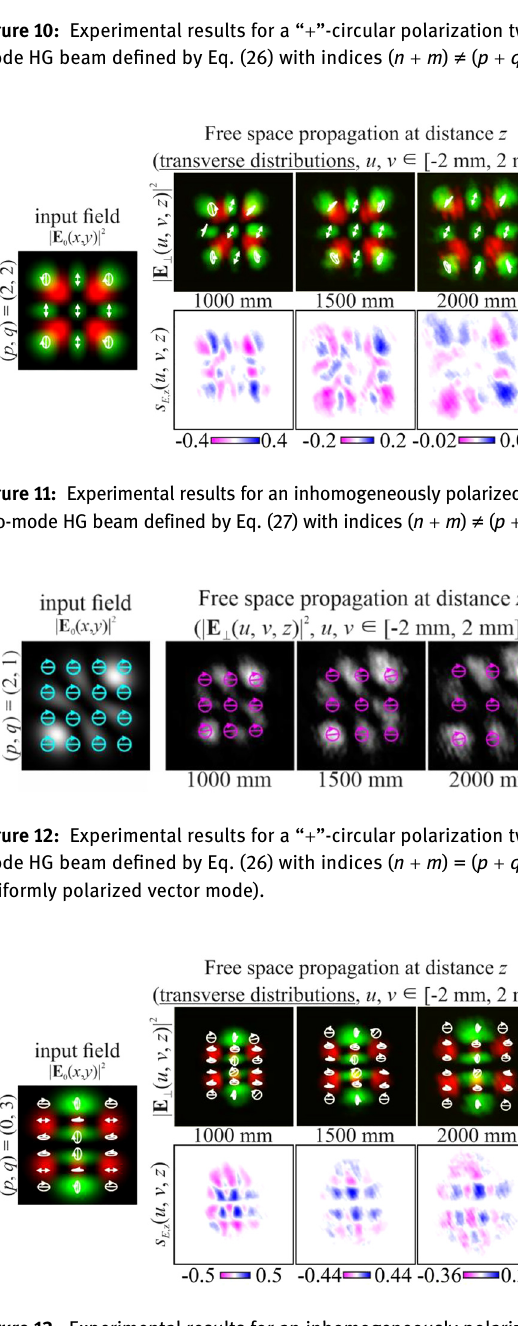
Figure 13: Experimental results for an inhomogeneously polarized two-mode HG beam defined by Eq. (27) with indices ( n + m ) = ( p + q ) (a nonuniformly polarized vector mode).